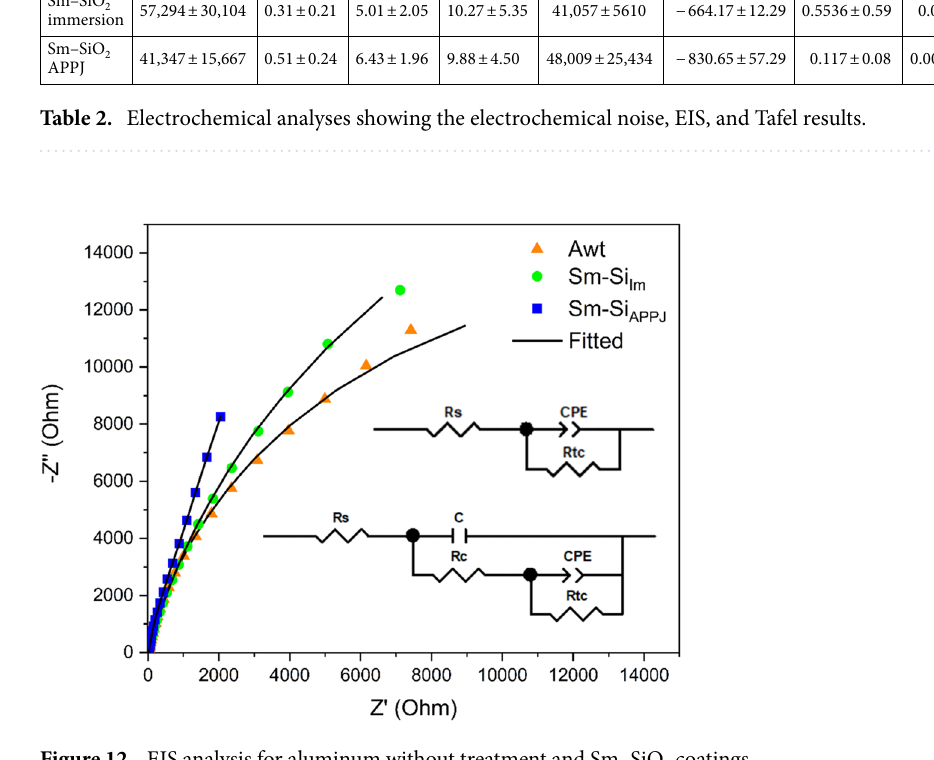
Figure 12. EIS analysis for aluminum without treatment and Sm–SiO 2